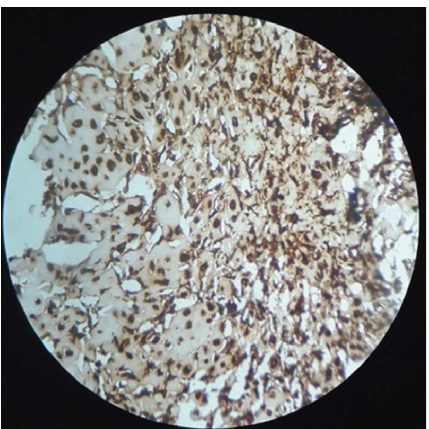
Figure 5: Immunostaining showing positivity for vimentin (H&E,